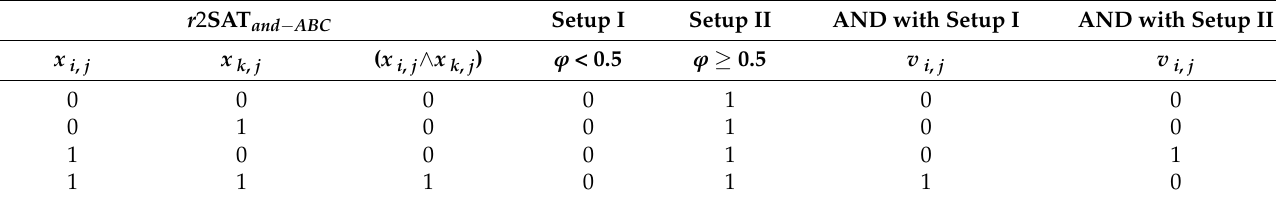
Table 9. The implication truth table for AND.